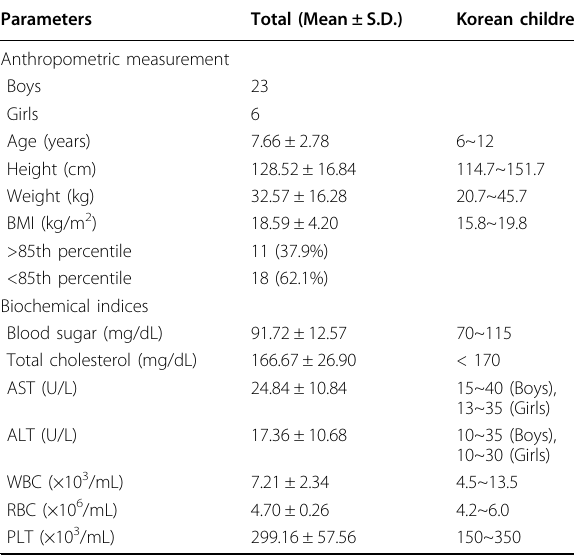
Table 1 General characteristics and biochemical indices of subjects.